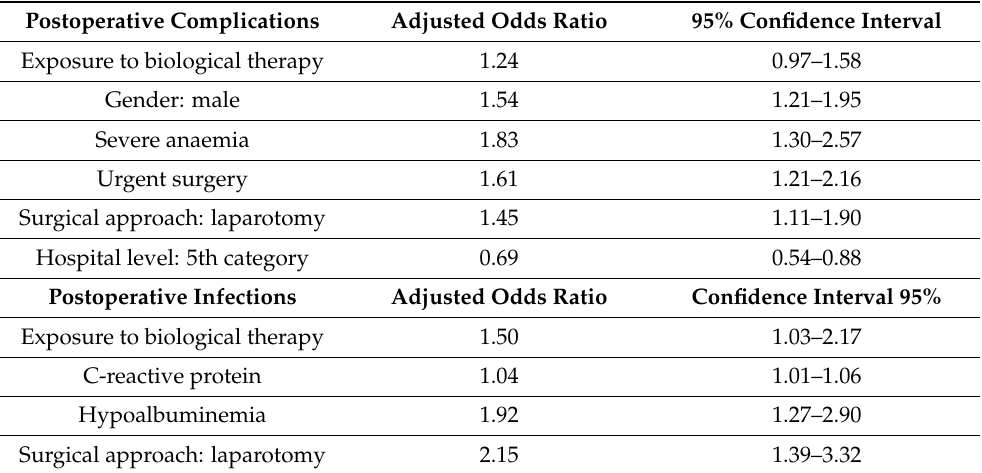
Table 5. Risk factors for postoperative complications and infections in the multivariate analysis calculated by logistic